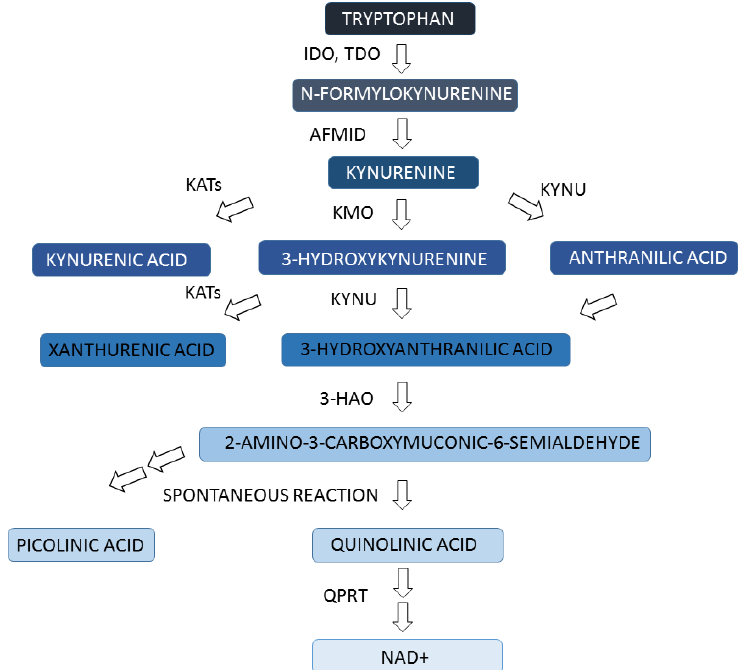
Figure 2. Simplified scheme of kynurenine pathway. The selected tryptophan metabolites and enzymes are shown in the scheme. AFMID — kynurenine formamidase, 3-HAO — 3-hydroxyanthranilate 3,4-dioxygenase, IDO — indoleamine-2,3-dioxygenase, KATs — kynurenine aminotransferases, KMO — kynurenine-3-monooxygenase, KYNU — kynureninase, NAD — nicotinamide adenine dinucleotide, QPRT — quinolinate phosphoribosyl transferase, TDO — tryptophan 2,3-dioxygenase.